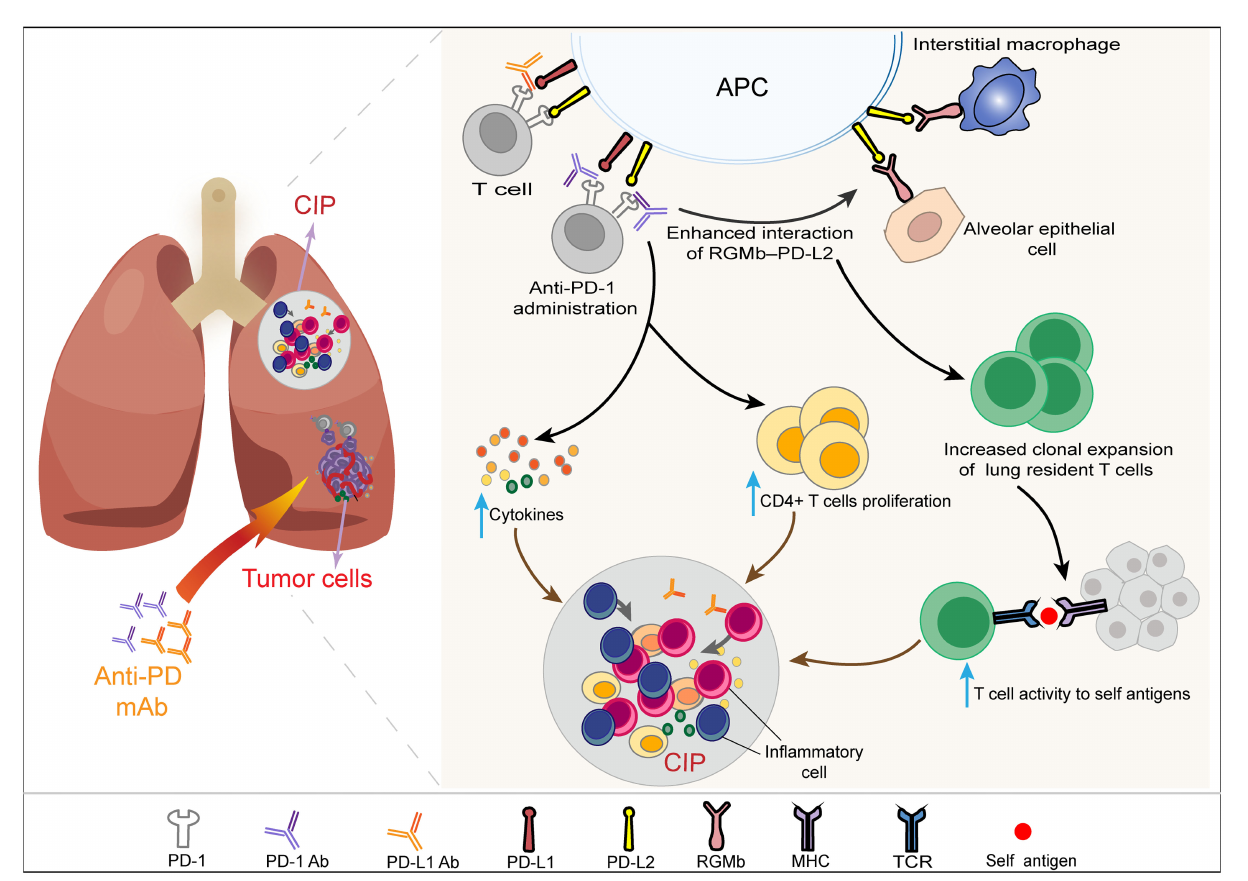
FIGURE 3 | Schematic diagram of the difference in the mechanism of CIP mediated by PD-L1 inhibitor and PD-1 inhibitor monotherapy. The mechanisms of checkpoint inhibitor pneumonitis (CIP) induced by PD-1 inhibitors and PD-L1 inhibitors in patients with NSCLC are not completely the same and may be related to PD-1 ligands, including PD-L1 and PD-L2. PD-L1 blockade does not in fl uence the binding between PD-L2 and its receptor PD-1, which is associated with immune tolerance in lung tissue. PD-1 inhibitors can simultaneously block the interaction between PD-1 and its ligands, including PD-L1 and PD-L2. The blockade of PD-1- PD-L2 signaling by PD-1 inhibitors has been observed to increase cytokine production and/or CD4+ T cell proliferation, which can increase the incidence and severity of CIP compared with PD-L1 inhibitors. Moreover, the application of a PD-1 inhibitor can increase the binding of PD-L2 to repulsive guidance molecule b (RGMb). RGMb has been observed to be expressed in lung interstitial macrophages, alveolar epithelial cells and other cells of the immune system. The interaction of RGMb – PD-L2 can increase T cell activity to self-antigens by increasing the clonal expansion of T cells that reside in the lung and then damage normal lung tissue. NSCLC, non-small cell cancer; CIP, checkpoint inhibitor pneumonitis; PD-1, programmed cell death protein 1; PD-L1, programmed cell death protein ligand-1; PD- L2, programmed cell death protein ligand-2; RGMb, repulsive guidance molecule